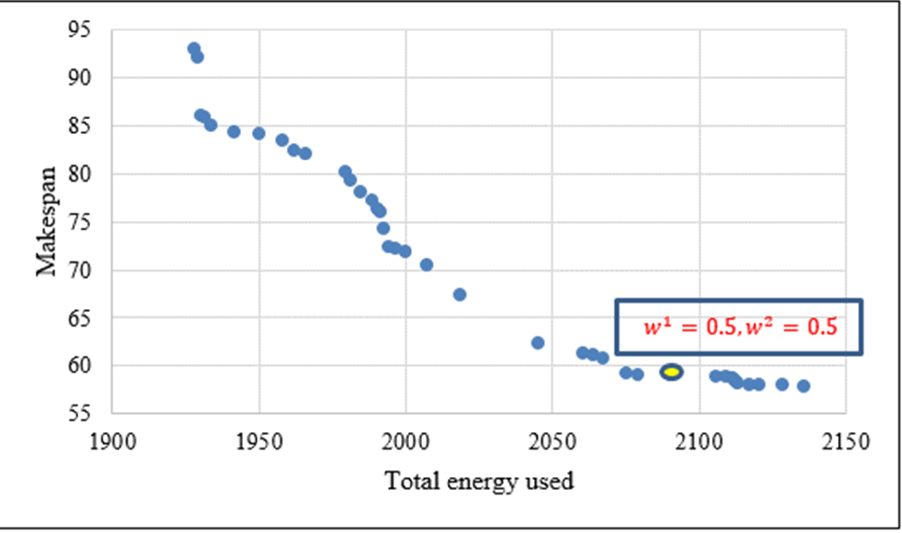
Figure 5. Pareto front of DE.